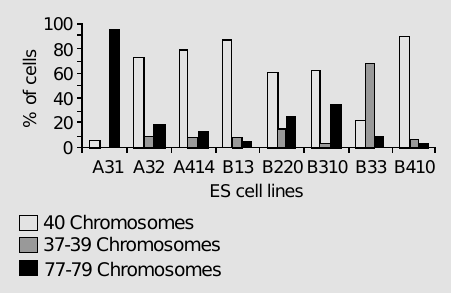
Figure 2. Alkaline phosphatase activity in embryonic stem (ES) cells. A , USP-2 (A414); B , B220. Undifferentiated ES cells (star) are stained positively and the feeder layer fibroblasts (arrows) and differentiated ES cells (tri- angle) are not stained.